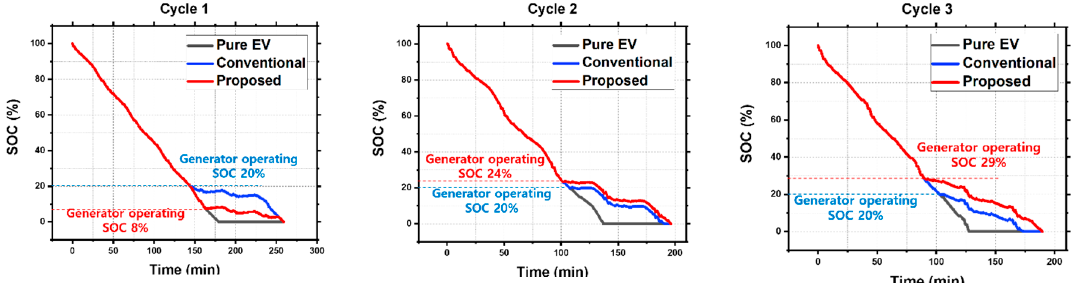
Figure 15. Application of the proposed algorithm with actual measurement data.